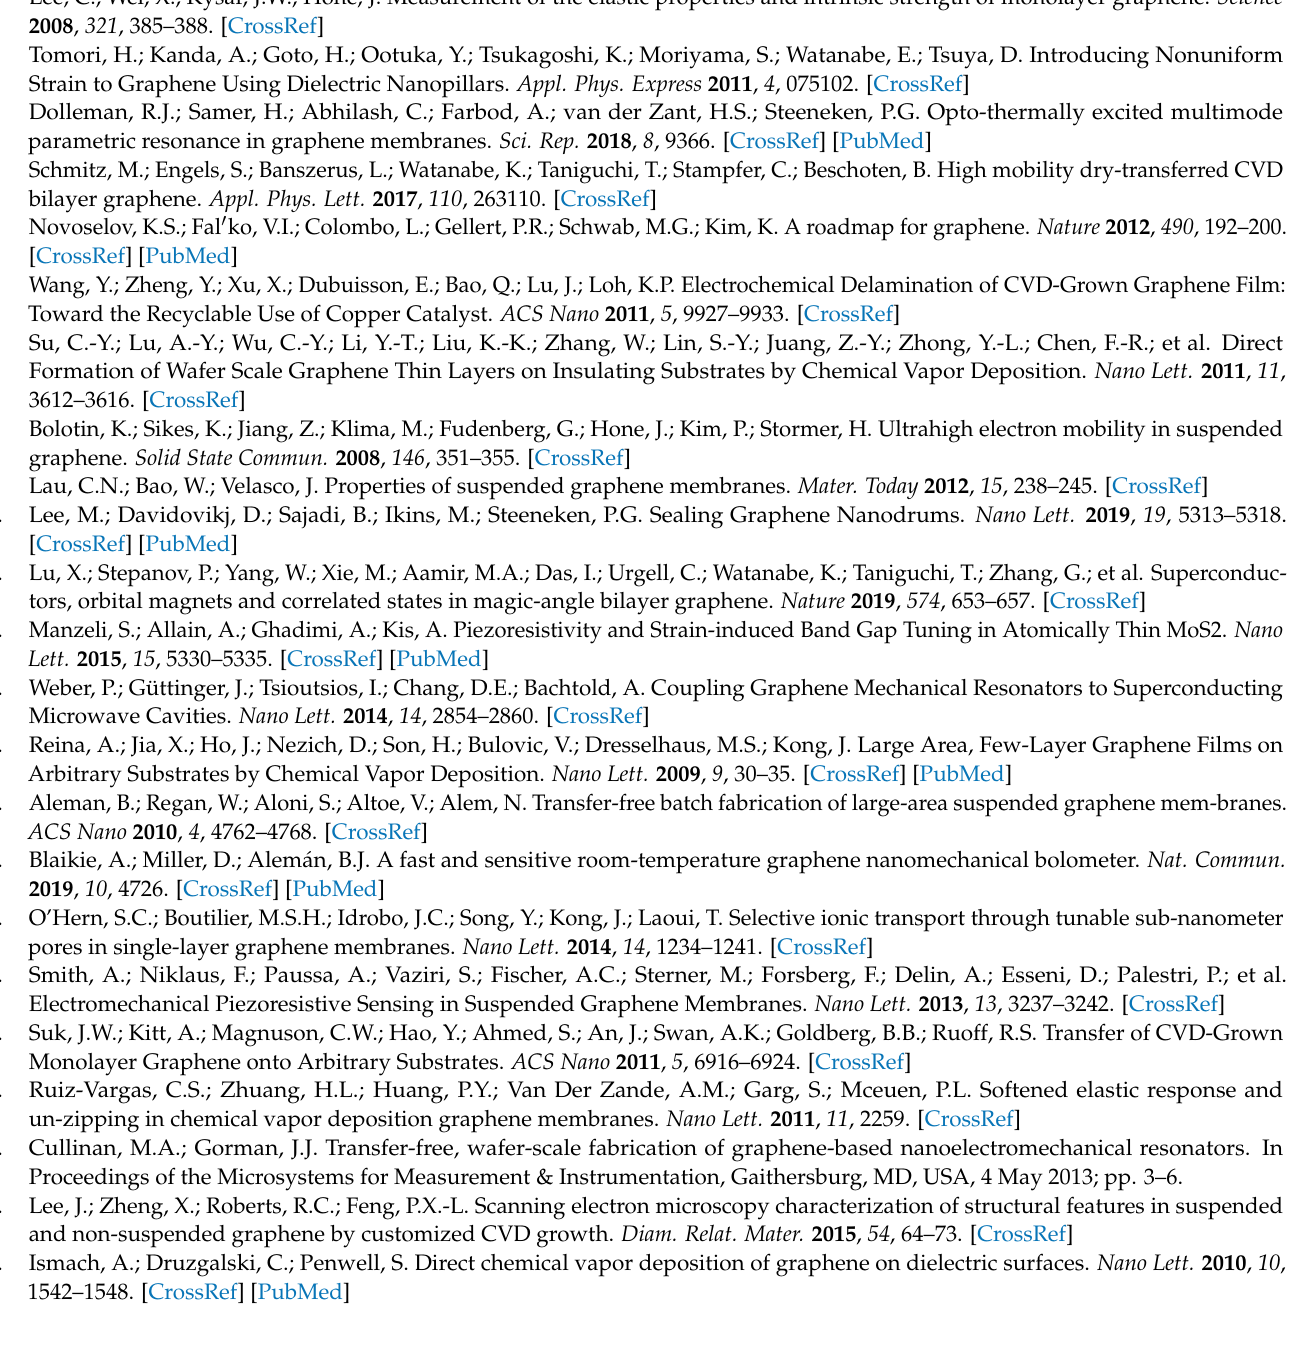
Table S1: Transfer success rate obtained from each